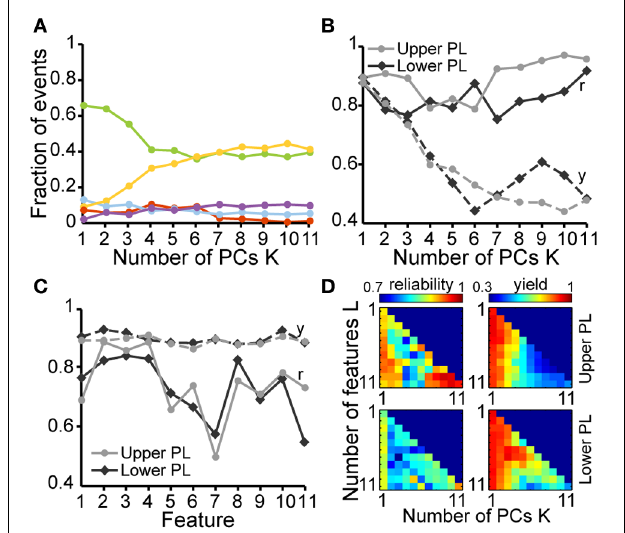
FIGURE 7 | Classification performance of the unsupervised method applied on the oscillatory events of pre-juvenile rats. (A) Fraction of TP (green), FP (red), and FN (yellow), SB and NG as well as FP (blue), and TN (purple) UC for different numbers of PCs used for the unsupervised classification. (B) Reliability (r, solid curves) and yield (y, dashed curves) of the unsupervised method in relationship to the number K of used PCs for the upper (light gray) and lower PL (dark gray). (C) Reliability and yield for an unsupervised classification that used only single features. Features 1–11 are shown in the same order as in Figure 3 . (D) Color plots displaying the reliability (left) and yield (right) of the unsupervised classification using different numbers of features (L) and PCs (K) for the upper (top) and lower (bottom) PL. For each row of the matrix, the same L features as in Figure 4F were taken into account. In (B,C) , lines connecting the data points are for illustrative